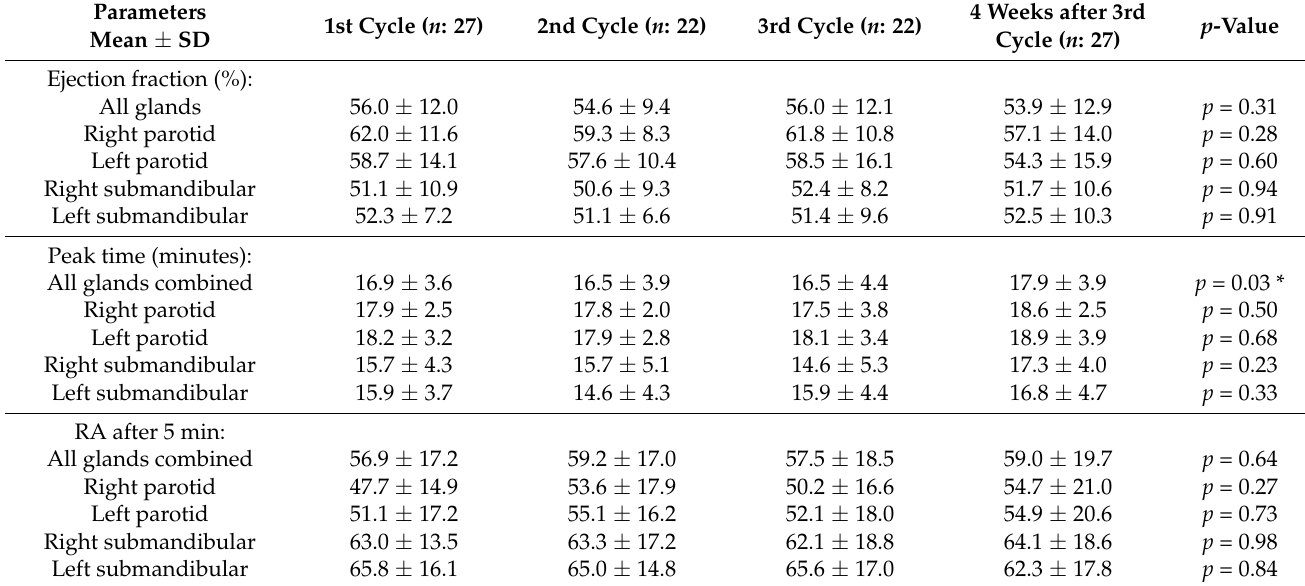
Table 2. Function of salivary glands directly before each cycle and 4 weeks after receiving 3 cycles of PSMA-RLT.